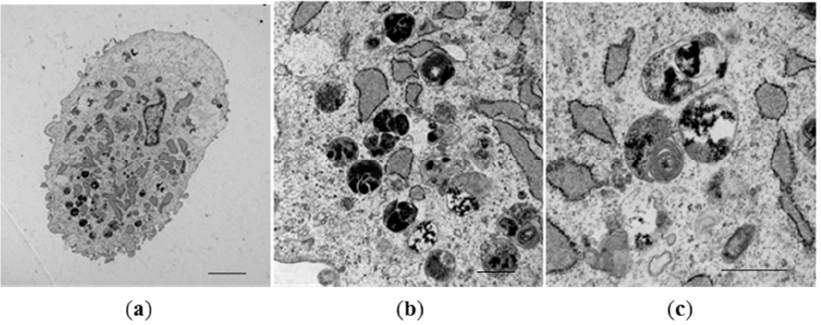
Figure 3. Expression of electron‐dense nanoparticles by mms6 ‐transfected MSCs. Representative TEM pictures of mms6 ‐expressing MSCs cultured for 15 days in medium containing ferric quinate. Scale bars: ( a ) = 10 µ m; ( b ) = 100 nm; ( c ) = 500 nm.